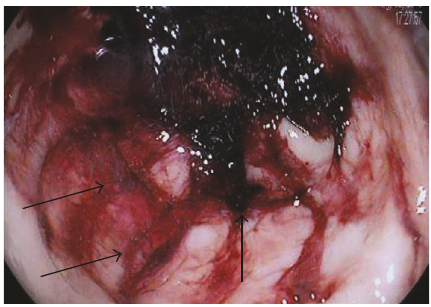
Figure3: Endoscopicimageof therectumwith asignificant amount of mucosal hemorrhage along with large ulcerations covered in hematin.